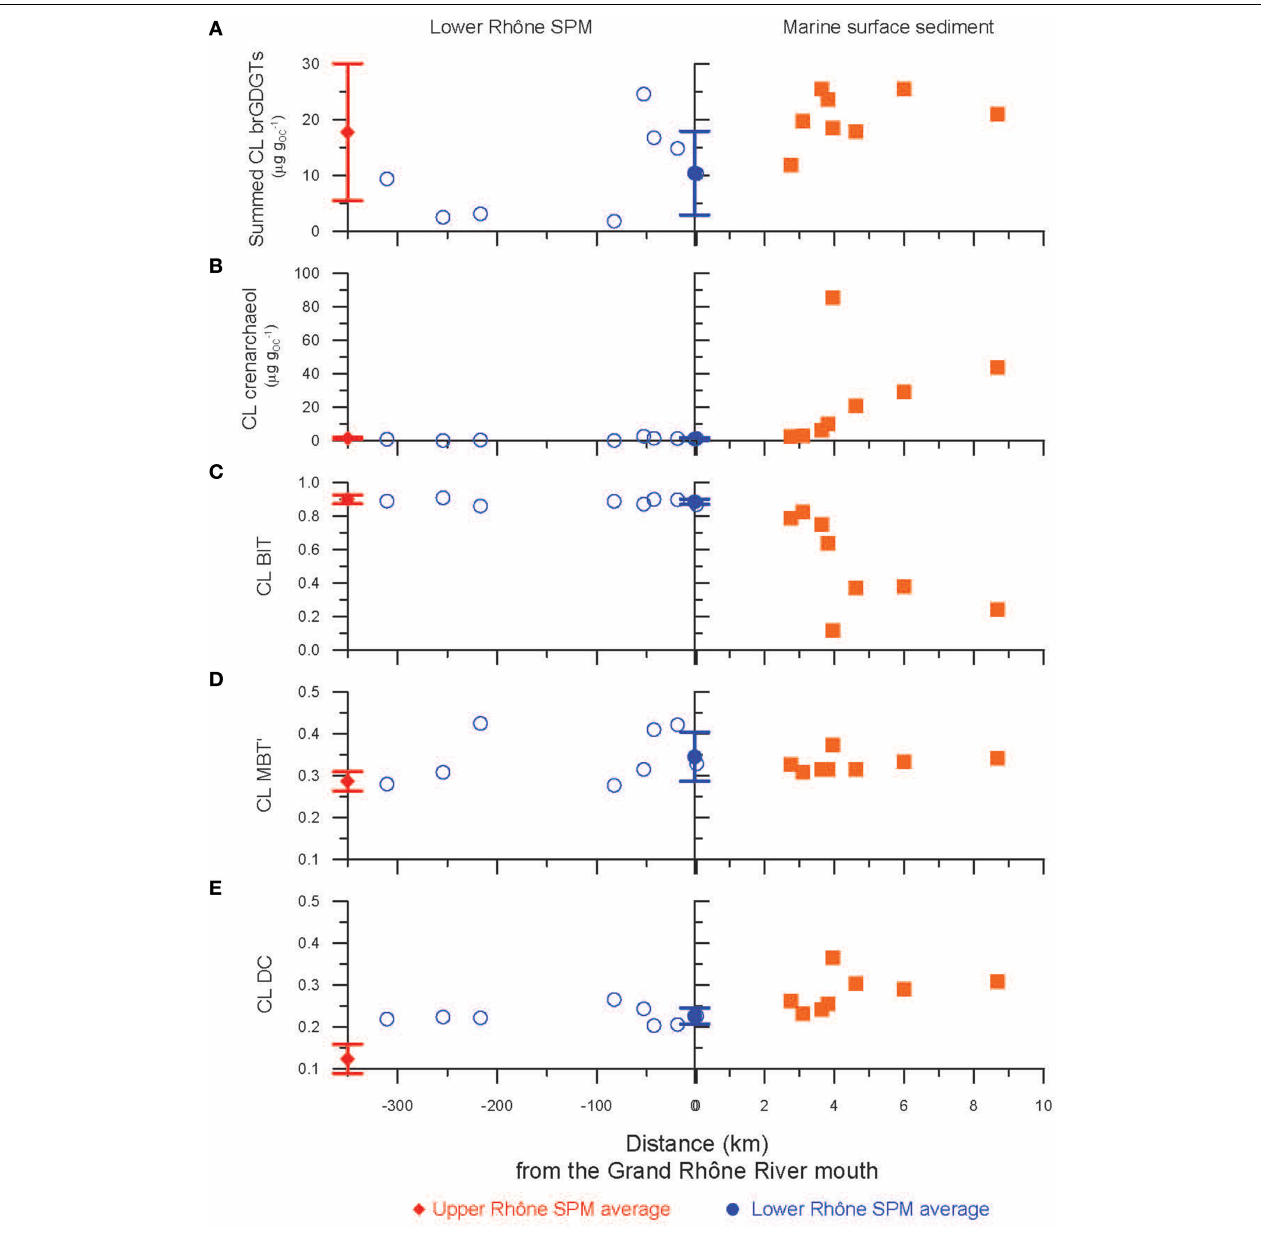
FIGURE 6 | Scatter plots of the distances from the Grand Rhône River mouth and (A) summed brGDGTs ( µ g g OC − 1 ), (B) crenarchaeol ( µ g g OC − 1 ), (C) the BIT index, (D) the MBT’, and (E) the DC of CL fractions from the lower Rhône SPM (open blue circles) as well as the marine